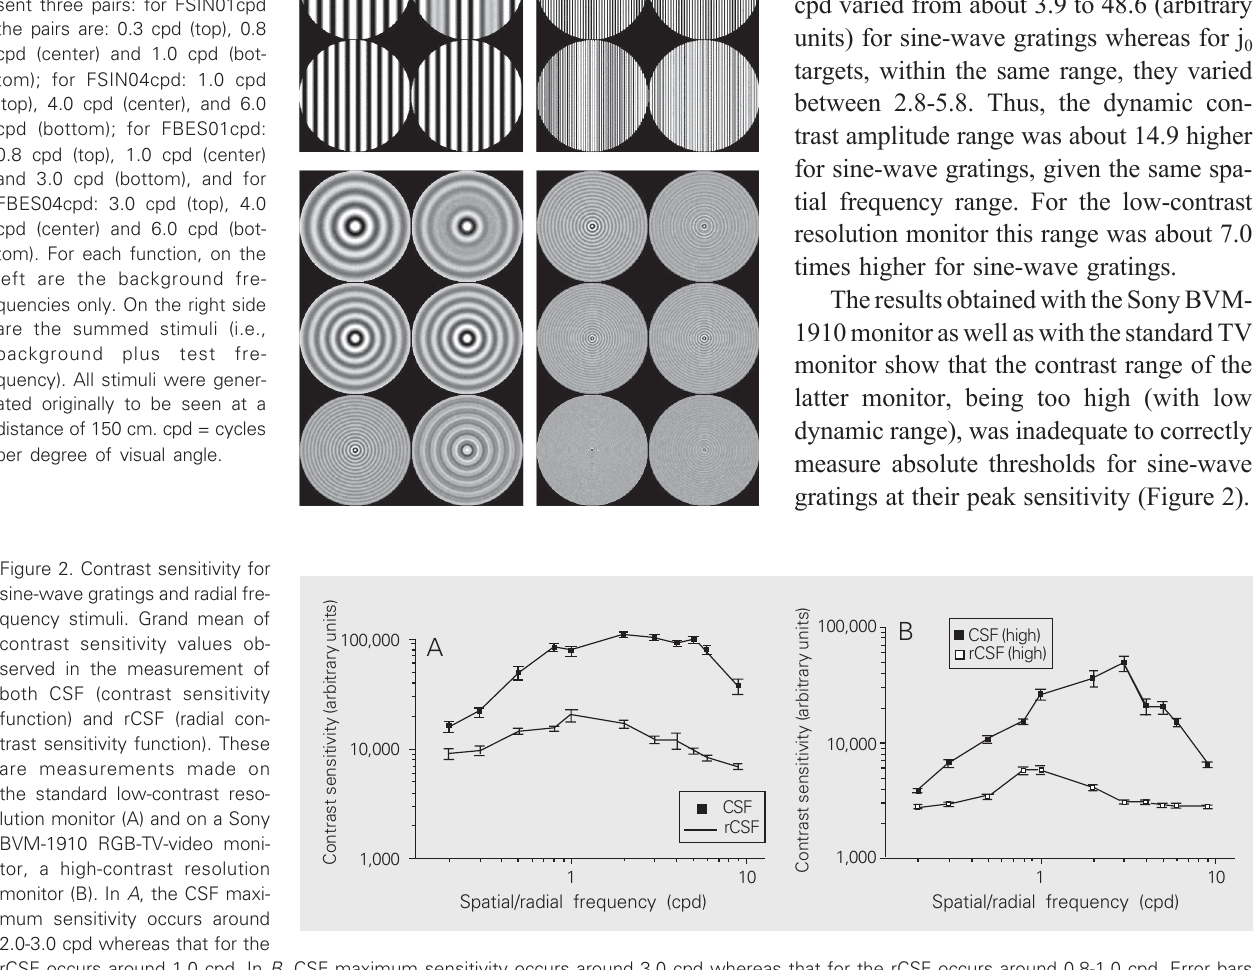
Figure 1. Example of pairs of stimuli used to measure F 1 (S) (or FSIN01cpd, top, left), F 4 (S)